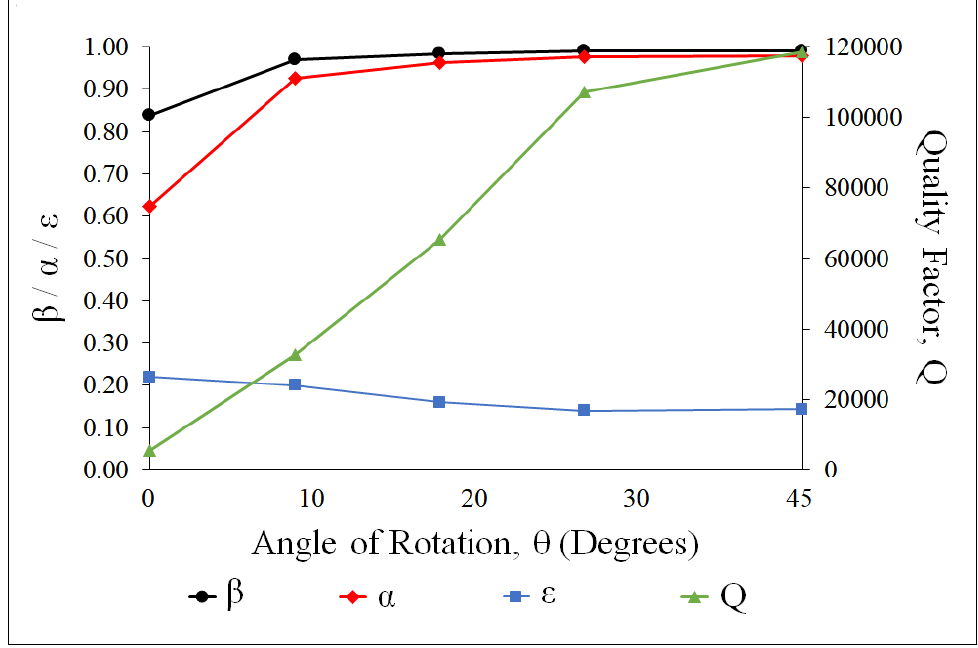
Figure 11. Optical parameters for an RCSS microresonator ( R c = 50 µ m) with varying angles of rotation in relation to the feed waveguide around the coupling